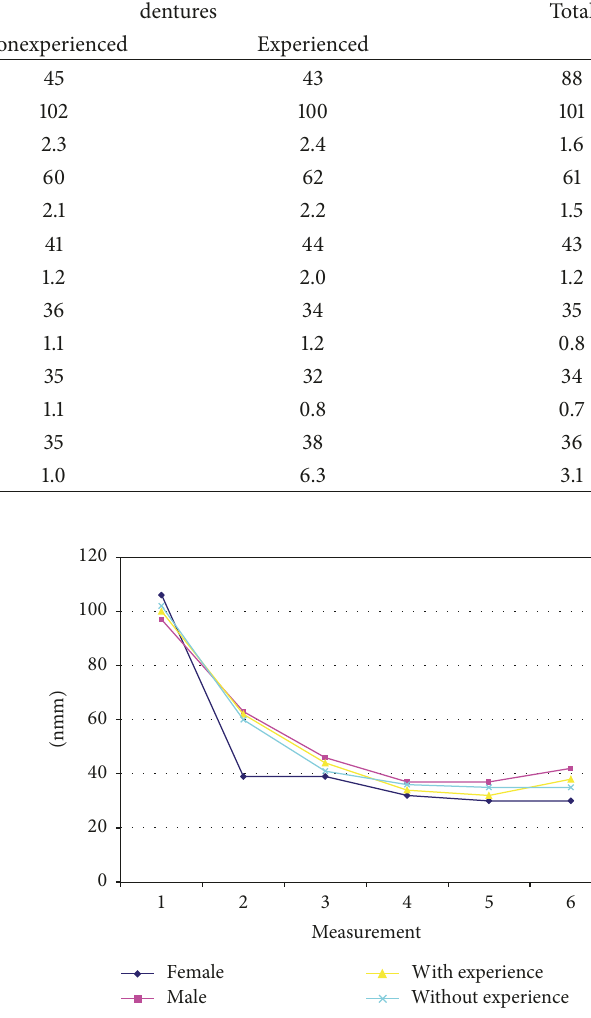
Figure 2: Dynamics of sensibility threshold for interocclusal thick- ness (gender and experience with complete